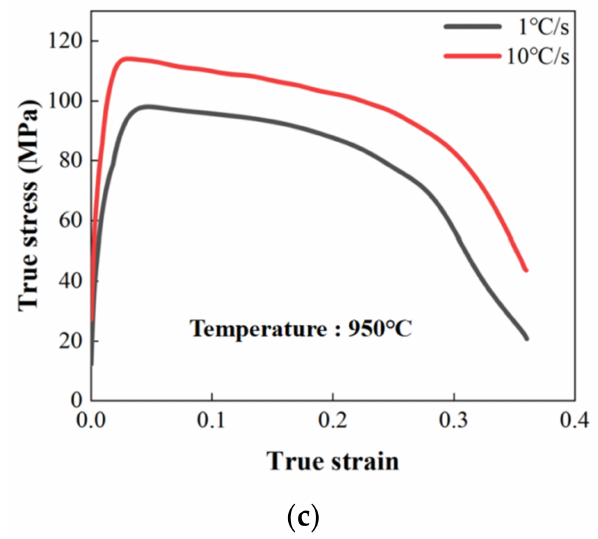
Figure 5. Effect of heating rate on the hot stress strain behaviors of TC4 at heating temperatures of